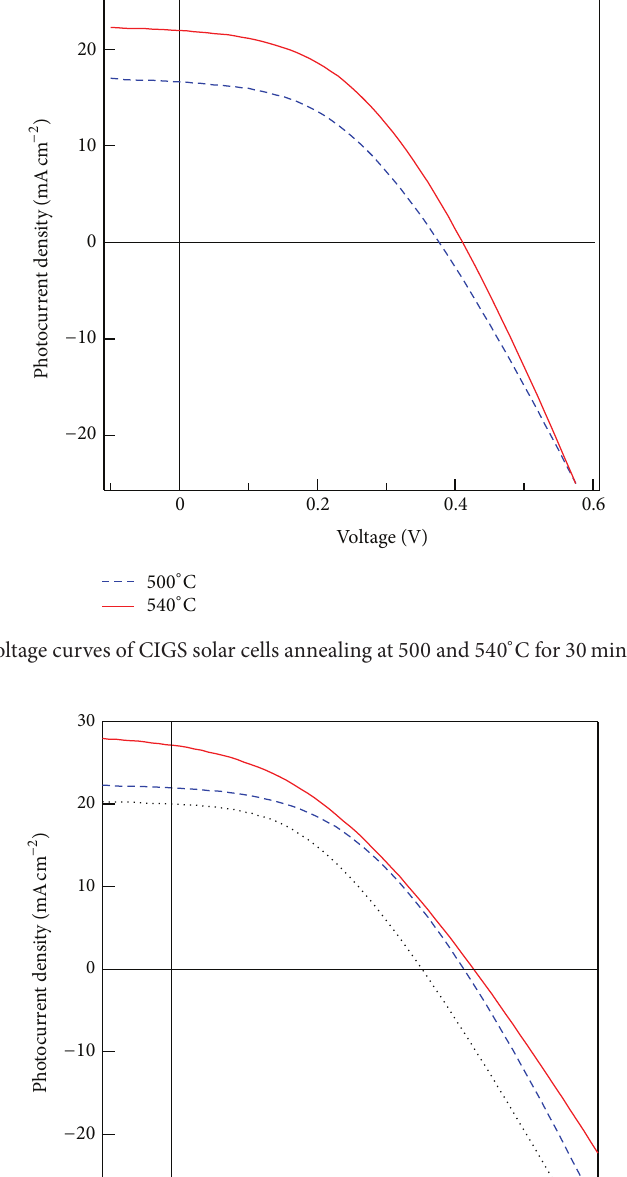
annealing; this phenomenon can be clearly viewed in the case of peak (112) as shown in the inset of Figure 2. The red arrow in the inset shows the position of the CIGS peak without annealing. The shift in XRD peaks is due to the replacement of sulfur by selenium in CIGS films. The